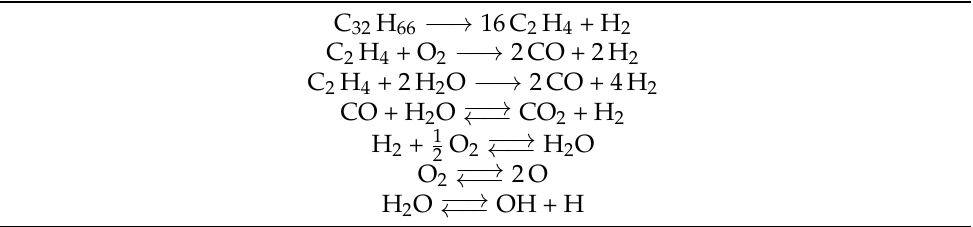
Chemical reactions involved in the global reaction mechanism used for paraffin– oxygen